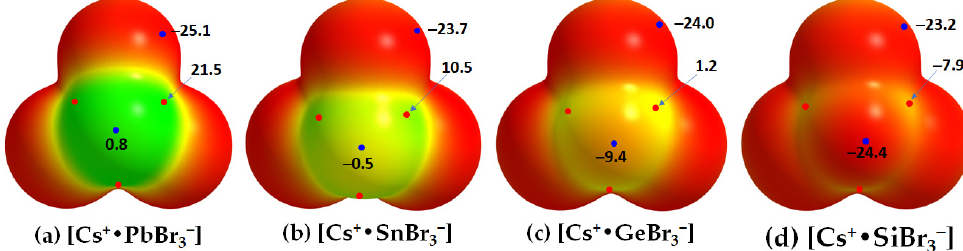
Figure 6. ( a – d ) The [ ω B97Xd/def2-TXVPPD]-calculated potential on the electrostatic surface of [Cs + •TtBr 3 − ] (Tt = Pb, Sn, Ge, Si), mapped on their corresponding 0.001 a.u. isoelectronic density envelopes. The Tt atom in [Cs + •TtBr 3 − ] faces the reader. Selected local most maxima and minima of potential ( V S,max and V S,min ) represented by tiny circles in red and blue, respectively, are depicted. Values are given in kcal mol − 1 . Regions colored blue and red refer to most positive and negative potential, respectively (regions in blue appeared on Cs are not shown).